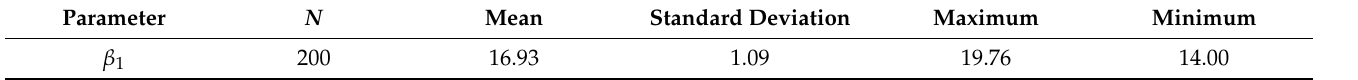
Figure 4. Histogram with distribution curve ( a ) and normal probability plot ( b ) of slope ( β 1 ) between σ c and I s of the limestone, from the least squares fit of 10 pairs of data points selected from 200 random samples. Table 9. Results of the normal distribution of the linear fit for the σ c and I s pairs of the